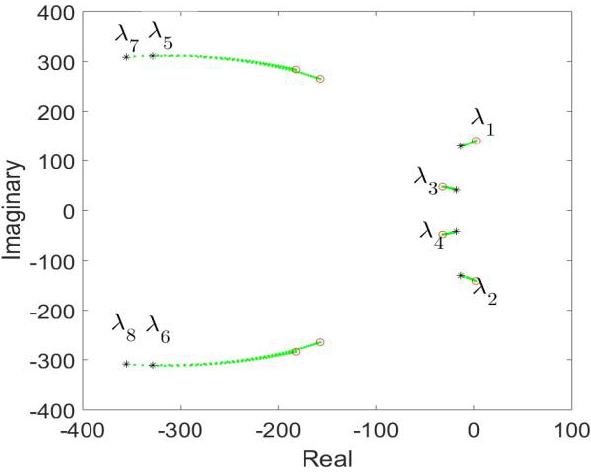
Figure 16. Eigenvalue loci of closed-loop system with SCR from 3 to 1.1.